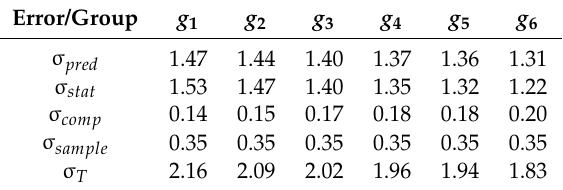
Table 3. Mean daily values of the error contributions to σ T (dB) for each group (acoustic map) g . The different symbols correspond to the intrinsic prediction error of the method, σ pred , the statistical variance of the equivalent noise levels measured by the monitoring stations, σ stat , the different cluster compositions for different time intervals, σ comp , and the error due to stratified sampling, σ sample